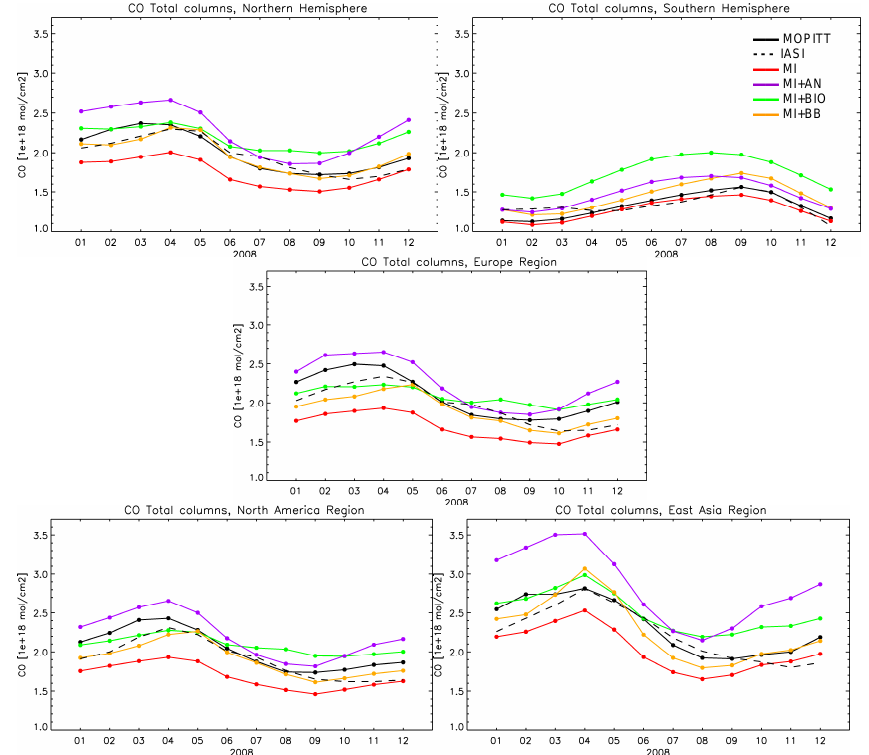
Figure 7. CO total columns from MOPITT and IASI satellite observations compared to 2008 monthly modelled columns from the MOZART simulations MI, MI + AN, MI + BIO, and MI +